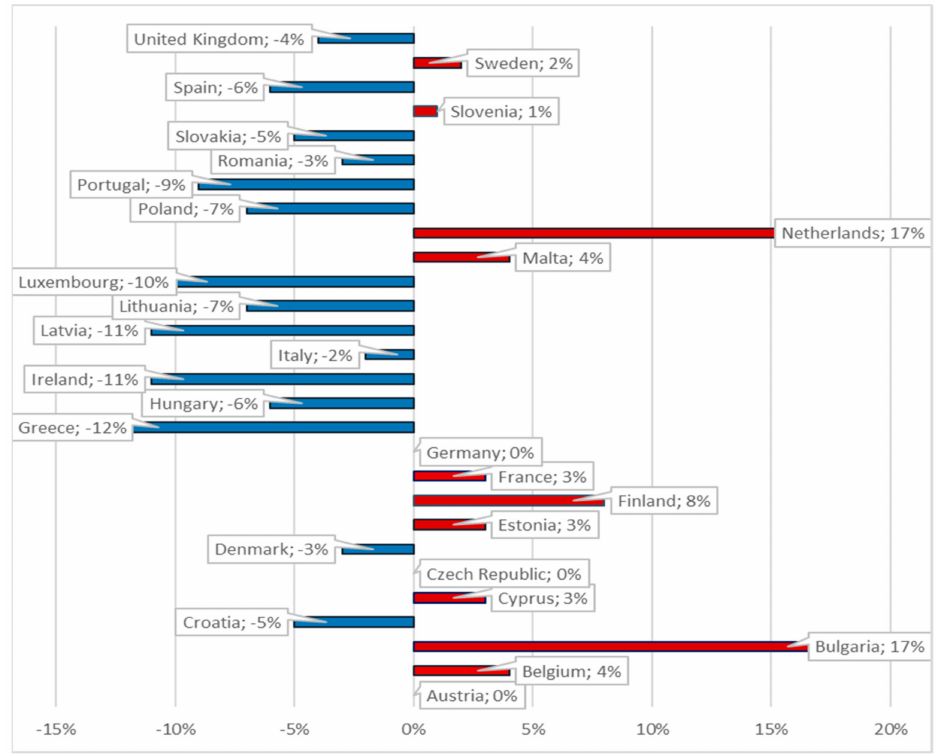
Figure 1. Healthcare expenditure (% of GDP) percentage change in 2010 and